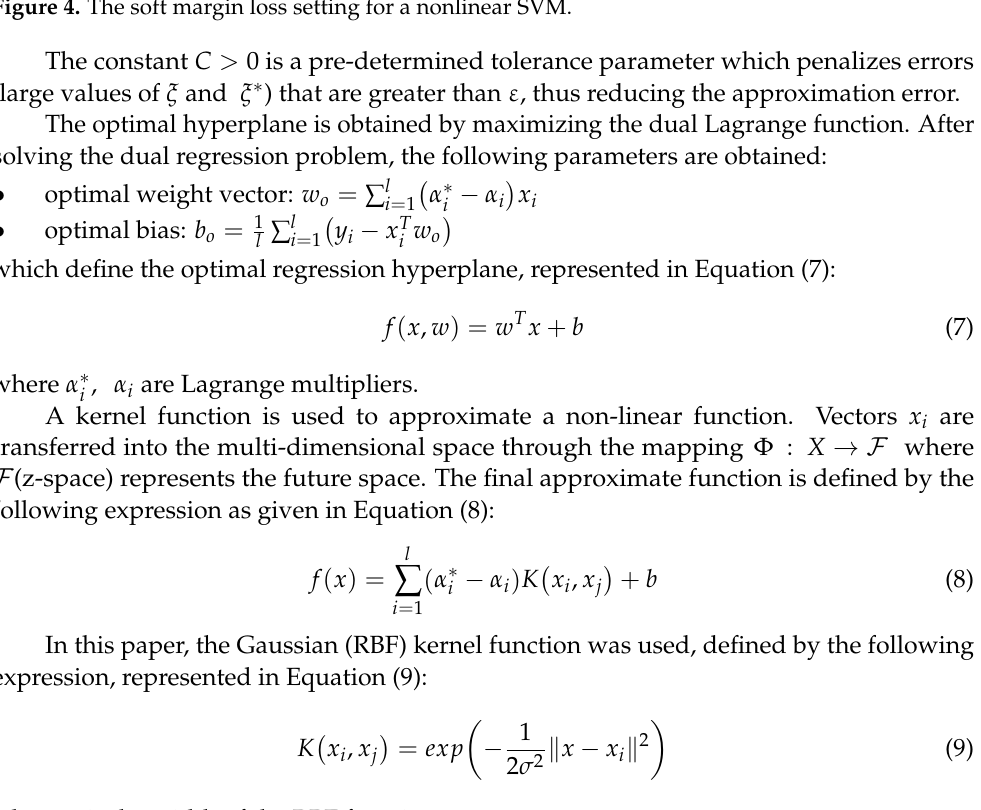
Table 1. SVM algorithm parameters.